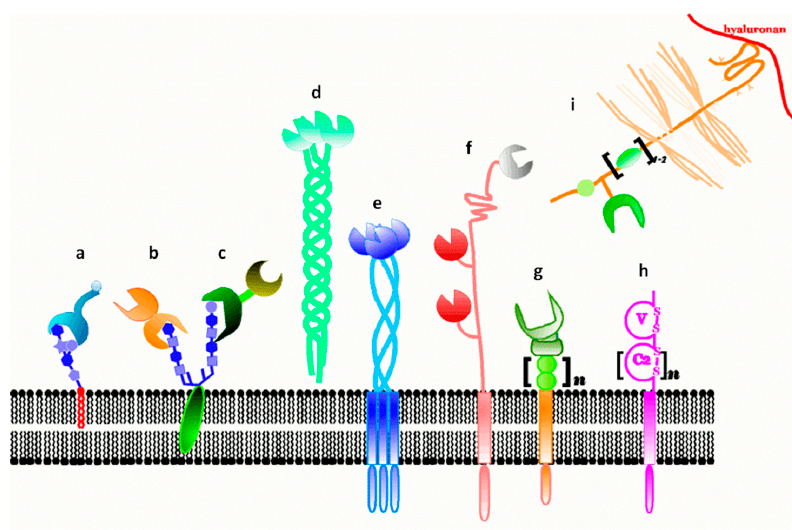
Figure 2. Illustration of the strategic ways that carbohydrate recognition domains (CRDs) in animal lectins are positioned to reach optimal ligand selection (for example, to separate self from non-self glycan profiles in innate immunity) and topological complementarity. From left to right, the CRD display in the three subtypes within the galectin family (chimera-type ( a ); proto-type ( b ) and tandem-repeat-type ( c ) arrangements binding to the saccharide portion of a ganglioside or a branched complex-type N -glycan without or with terminal α 2,3-sialylation; please see also Figure 3), the presentation of CRDs (C-type or fibrinogen-like domain) in serum and surfactant collectins or ficolins ( d ) connected to their collagenous stalks and the non-covalent association of binding sites in transmembrane C-type lectins by α -helical coiled-coil stalks ( e ) (for example asialoglycoprotein and Kupffer cell receptors, the scavenger receptor C-type lectin, CD23, DC-SIGN or DC-SIGNR) are given. Similar to tandem-repeat-type galectins, the C-type family of lectins also has a branch of members with this design, i.e. , immulectins-1, -2 and -3. Next, the tandem-repeat display in the mannose-specific macrophage receptor ( f ) (also found on dendritic cells, hepatic endothelial cells, kidney mesangial cells, retinal pigment epithelial cells and tracheal smooth muscle cells) and the related C-type lectin Endo180 with eight domains as well as in the cation-independent P-type lectin with 15 domains is presented. Capacity for sugar binding is confined to only few domains as depicted. The occurrence of lectin activity for GalNAc-4-SO 4 -bearing pituitary glycoprotein hormones in the cysteine-rich domain, a member of the β -trefoil fold family with one (QxW) 3 domain in the N -terminal section of the macrophage mannose receptor (amino acids 8–128), which is linked via a fibronectin-type-II-repeat-containing module to the tandem-repeat section, is also included into the schematic drawing for these lectins with more than one type of CRD per protein chain. Moving further to the right side; ( g ) the association of a distal CRD in selectins (attached to an epidermal-growth-factor (EGF)-like domain and two to nine complement-binding consensus repeats) or in the siglec subfamily of I-type lectins using 1–16 C2-set immunoglobulin-like units as spacer equivalents to let the CRD reach out to contact ligands and to modulate capacity to serve in cis - or trans -interactions on the cell surface is shown. The force-dependent alterations of the topological arrangement of the two distal domains in selectins accounts for catch bonds of selectins, a canonical immunoreceptor tyrosine-based inhibitory motif (ITIM) together with a putative tyrosine-based motif is frequently present in the intracellular portion of siglecs. C2-set domains linked to fibronectin-type-III repeats establish the extracellular section of the I-type lectins L1 and neural cell adhesion molecule (NCAM) ( h ). In the matrix, the modular proteoglycans (i) (hyalectans/lecticans: aggrecan, brevican, neurocan and versican) interact (i) with hyaluronan (and also link protein) via the link-protein-type modules of the N -terminal G1 domain (and an Ig-like module); (ii) with receptors binding to the glycosaminoglycan chains in the central region and (iii) with carbohydrates or proteins (fibulins-1 and -2 and tenascin-R) via the C-type lectin-like domain flanked by EGF-like and complement-binding consensus repeat modules (kindly provided by H. Kaltner) (from [38], with